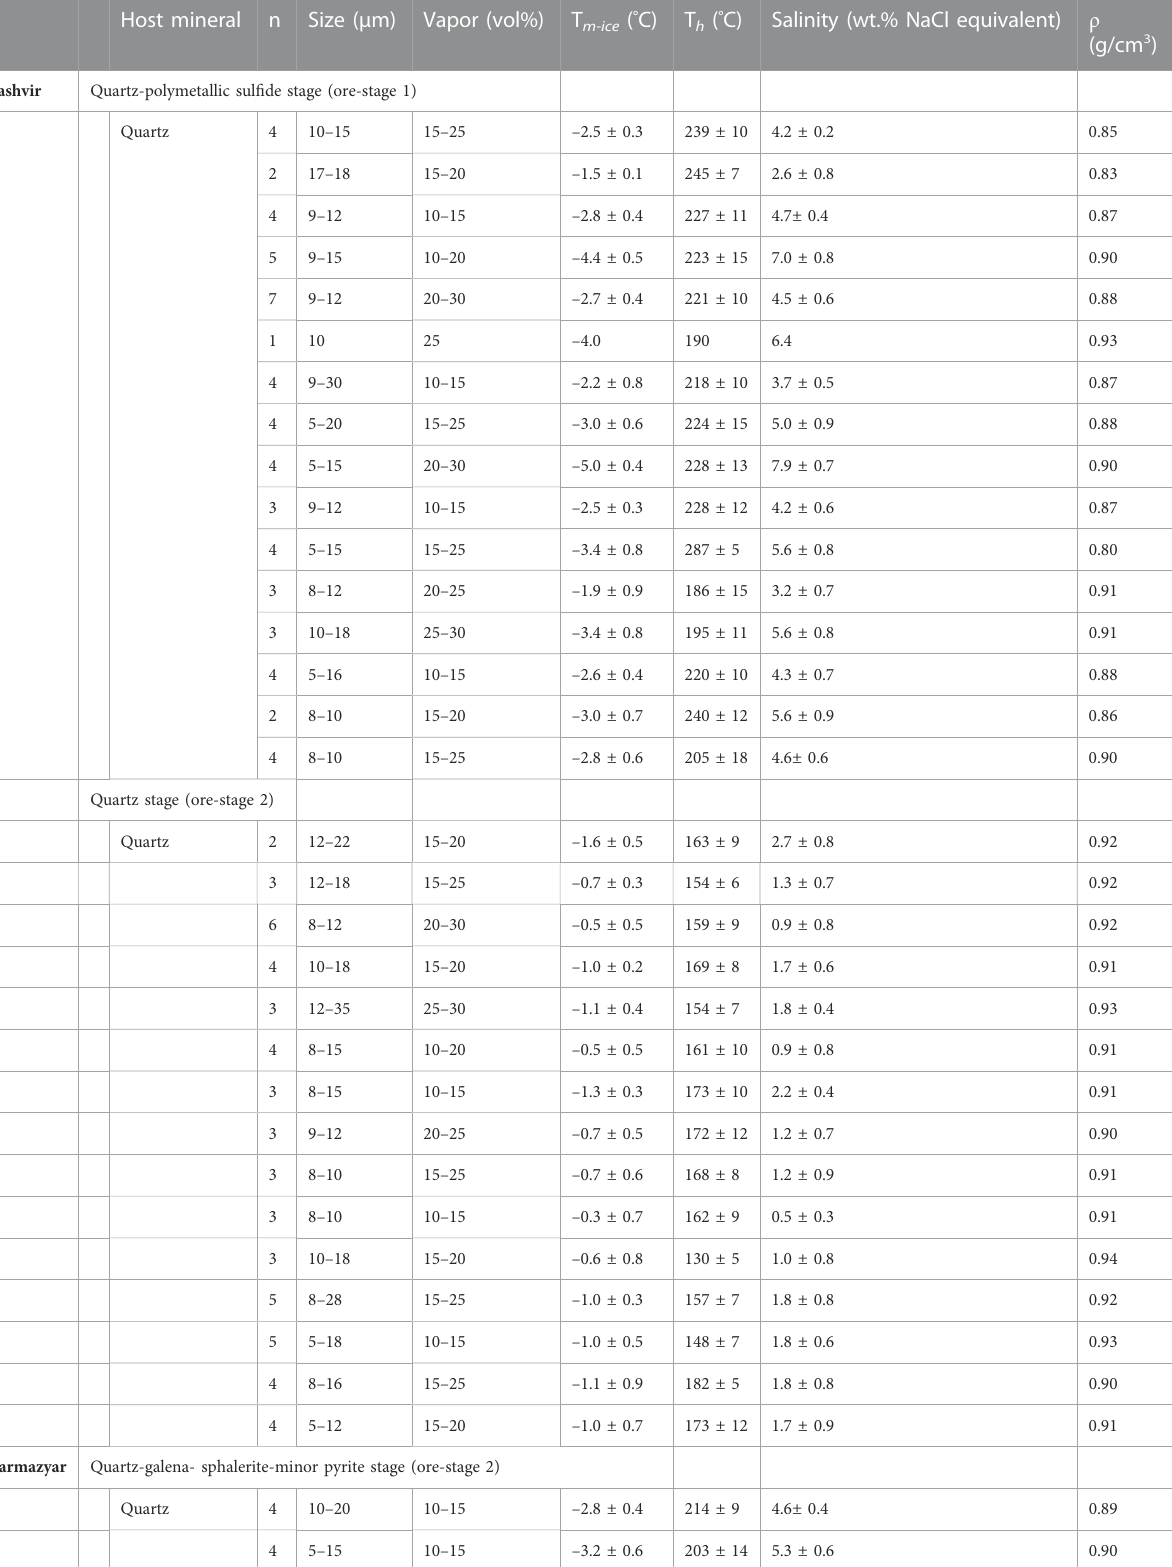
TABLE 2 Microthermometric data for primary type 1 fl uid inclusion assemblages from Tashvir and Varmazyar deposits.